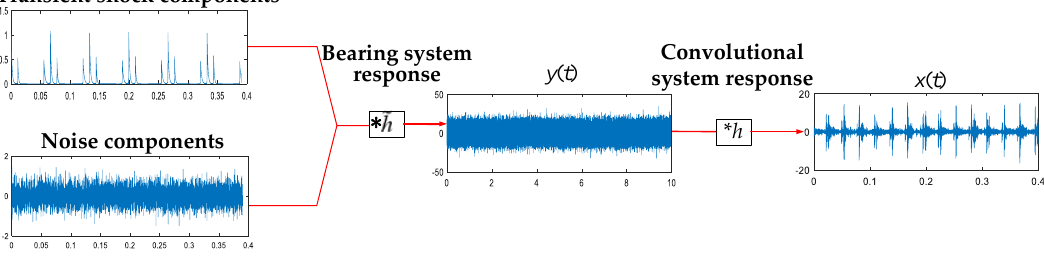
Figure 1. The procedure illustrating transient feature extraction.